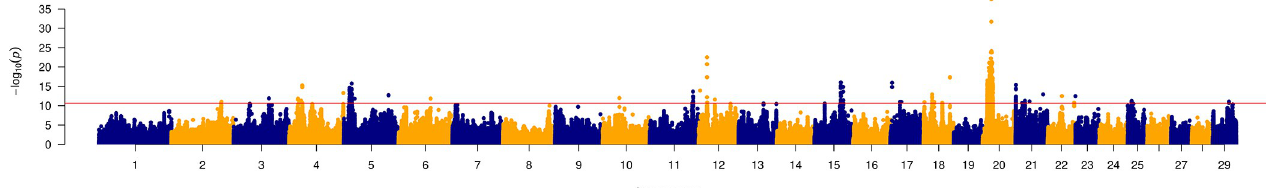
Fig 3. Manhattan plots showing the GWAS results from contrasting GWH animals with the ACOP phenotype and those of the Dutch Belted, Deep Red, Meuse-Rhine-Yssel, Dutch Friesian, and Holstein Friesian breeds without white head and non-ACOP phenotype. The y-axis of the plot represents the -log 10 ( P -values) from the GWAS and the x-axis shows the genomic location of each variant. The horizontal red line indicate the significant association ( q-value � 0.001) at the genome-wide